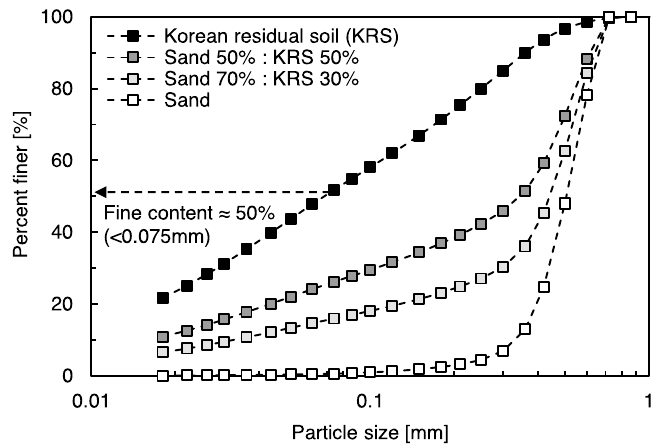
Figure 2. Particle size distribution of sand and Korean residual soil.